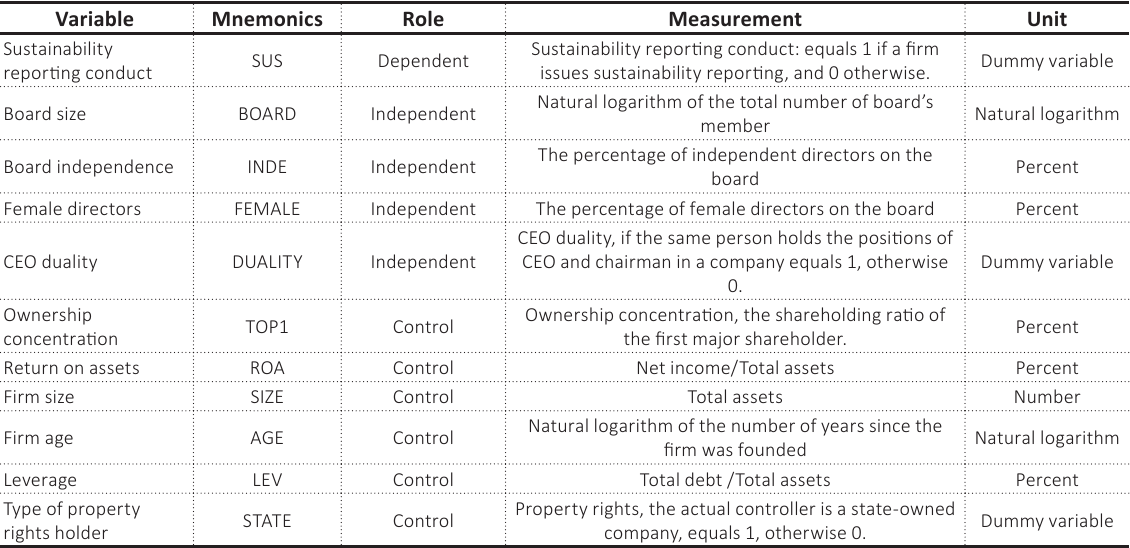
Table 3. Description of the variables